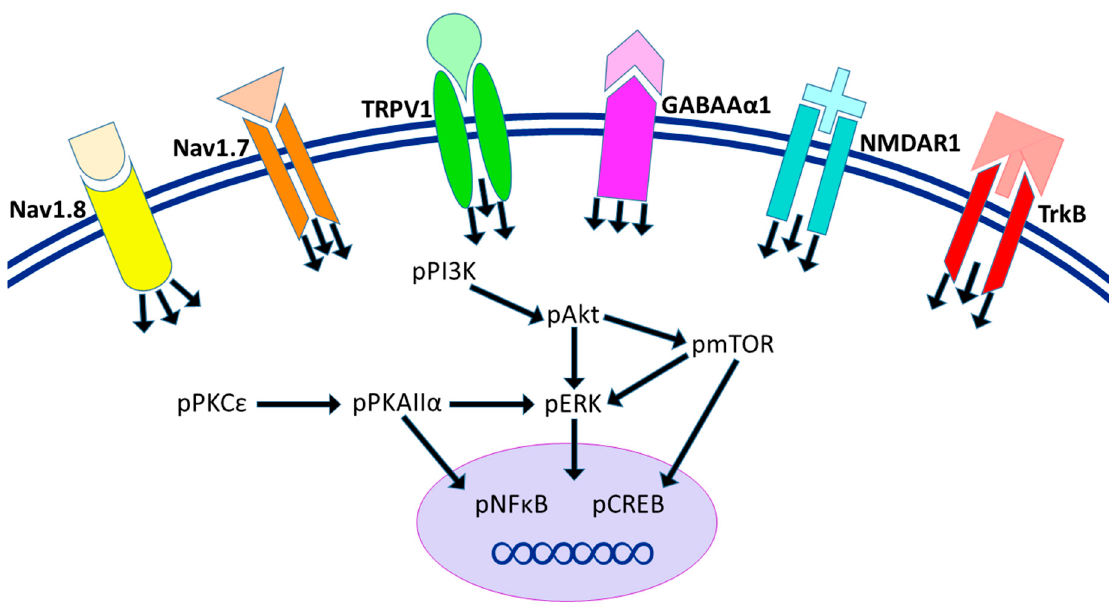
Figure 7. Illustration of CPDC pathways attenuated by EA in the cerebellum. We found that EA at 1 mA, 2 Hz/20 min, and TRPV1 gene deletion can increase the expressions of TRPV1, Nav1.7, Nav1.8, GABAA α 1, NMDAR1, and TrkB receptors in the AS-induced CPDC model, as observed in the AS + EA and AS + KO groups. Furthermore, the relevant increases in related responses cause effective increases in the signaling of pPI3K, pAkt, pERK, pmTOR, pPKC ε , pPKAII α , pNF κ B, and pCREB under conditions of CPDC, and these serve to present a basic neuromodulatory pathway of CPDC, TRPV1 signaling, and the molecular function of